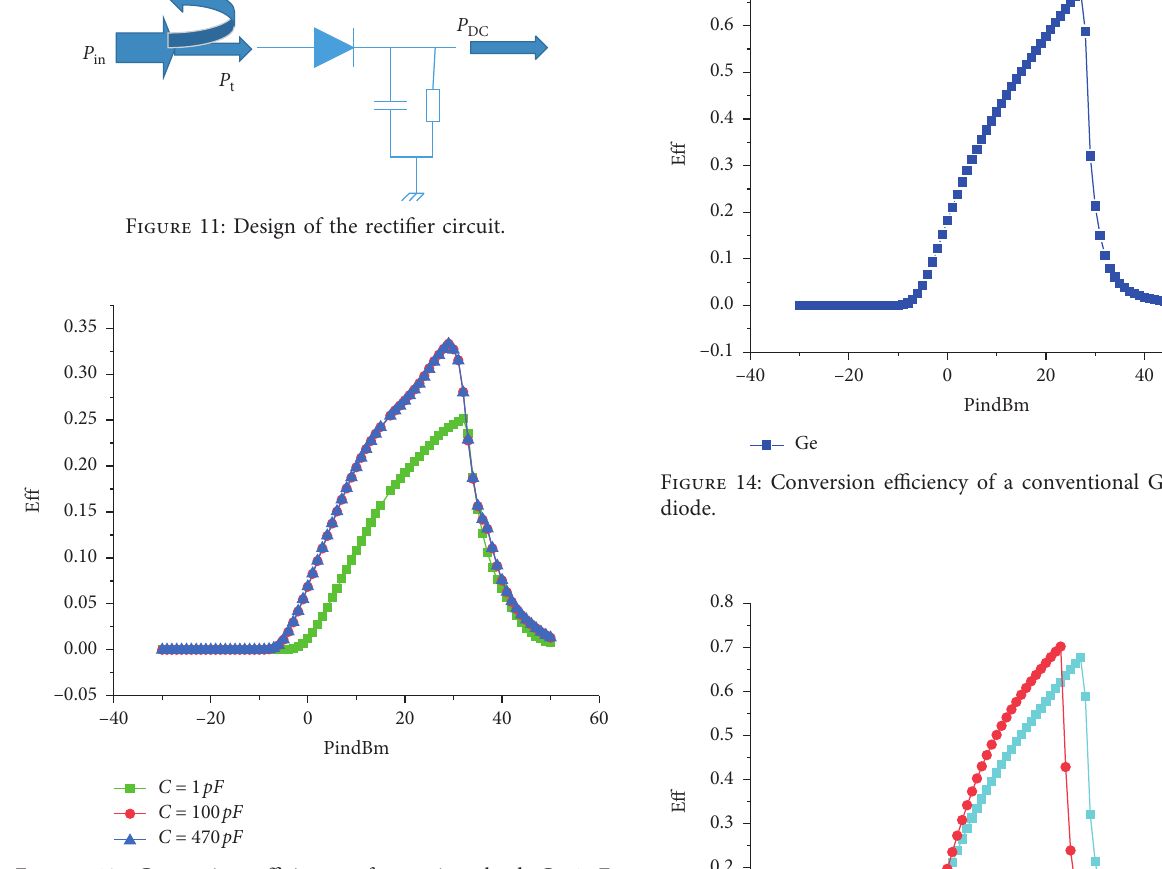
Figure 12: Conversion efficiency of capacitor load C � 1pF, C � 100pF, and C � 470pF in the rectifier circuit.